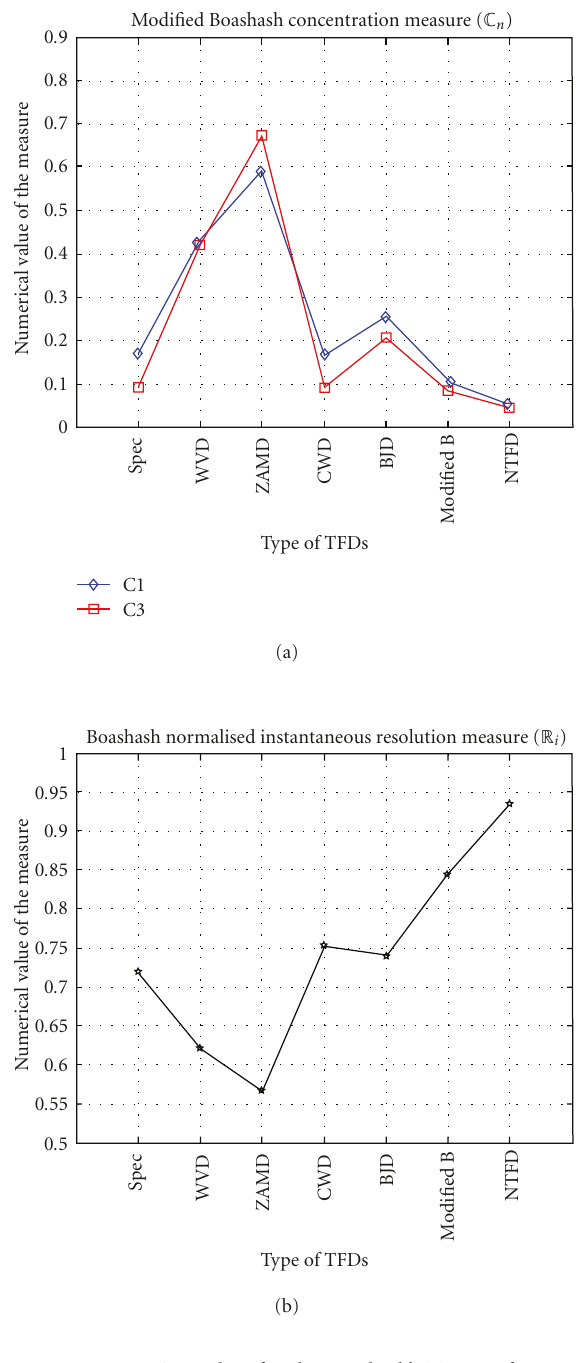
Figure 7: Comparison plots for the Boashash’s TFD performance measures versus di ff erent types of TFDs, (a) The proposed modified Boashash’s concentration measure ( C n (64)), and (b) The Boashash’s normalized instantaneous resolution measure ( R i